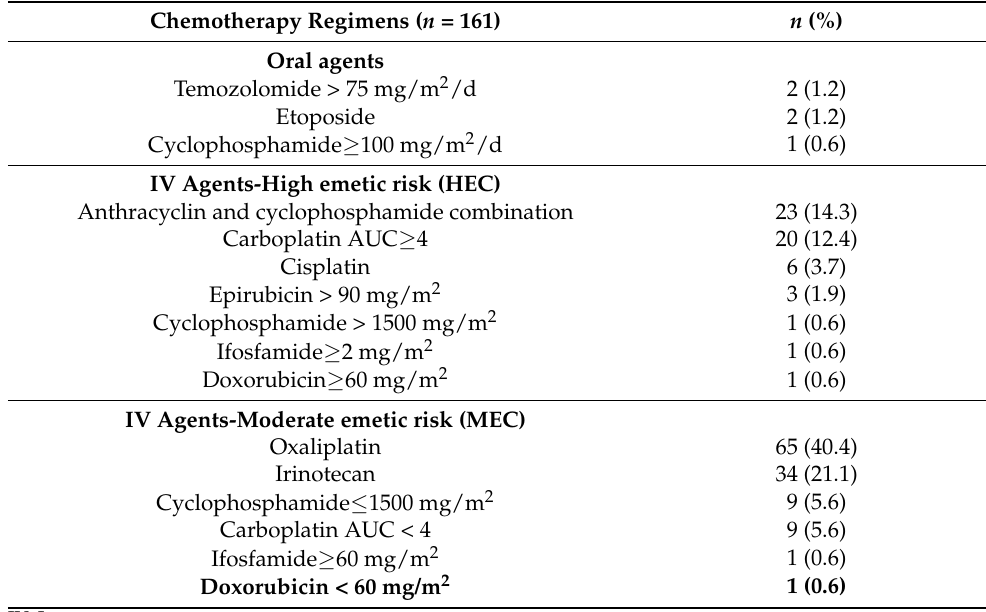
Table 2. Current chemotherapy regimens.